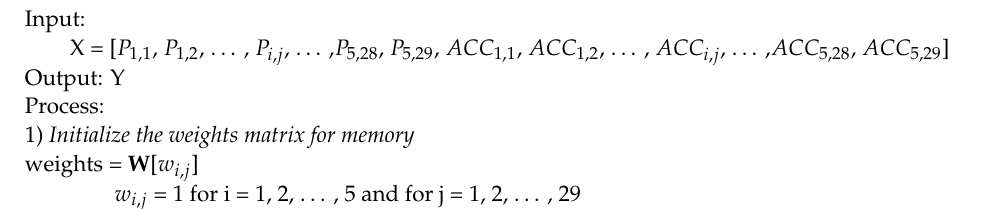
Algorithm 1. The AWV algorithm for ASL letter recognition ( α = 2, λ =